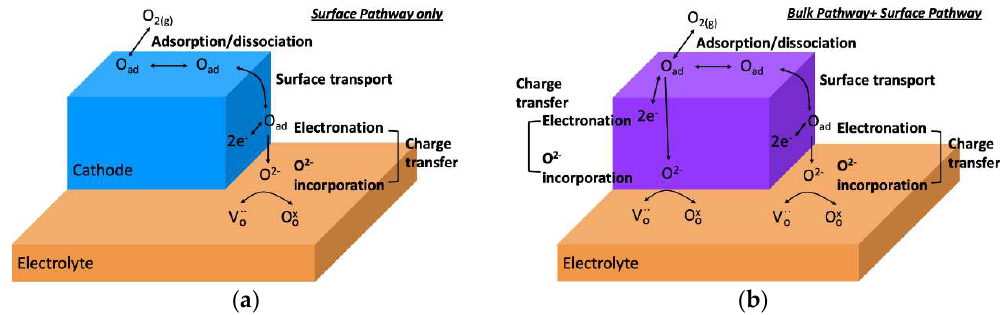
Figure 1. Schematic of possible elementary reaction steps during oxygen reduction reaction (ORR) and possible pathways for two different classes of cathode materials; ( a ) pure electronic conductor and ( b ) mixed ionic and electronic conducting (MIEC) cathodes.